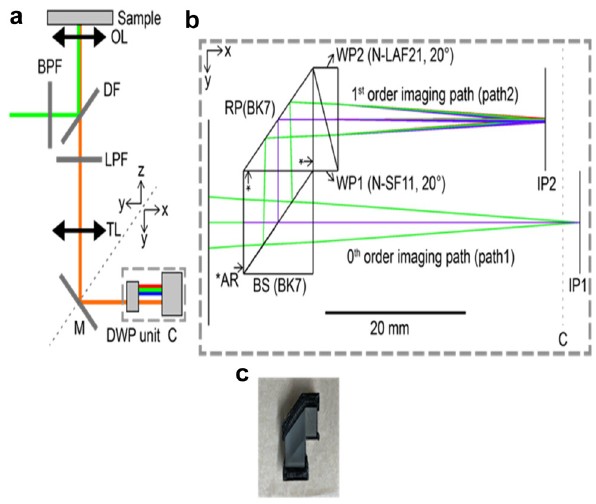
Figure 1: 3D DWP sSMLM